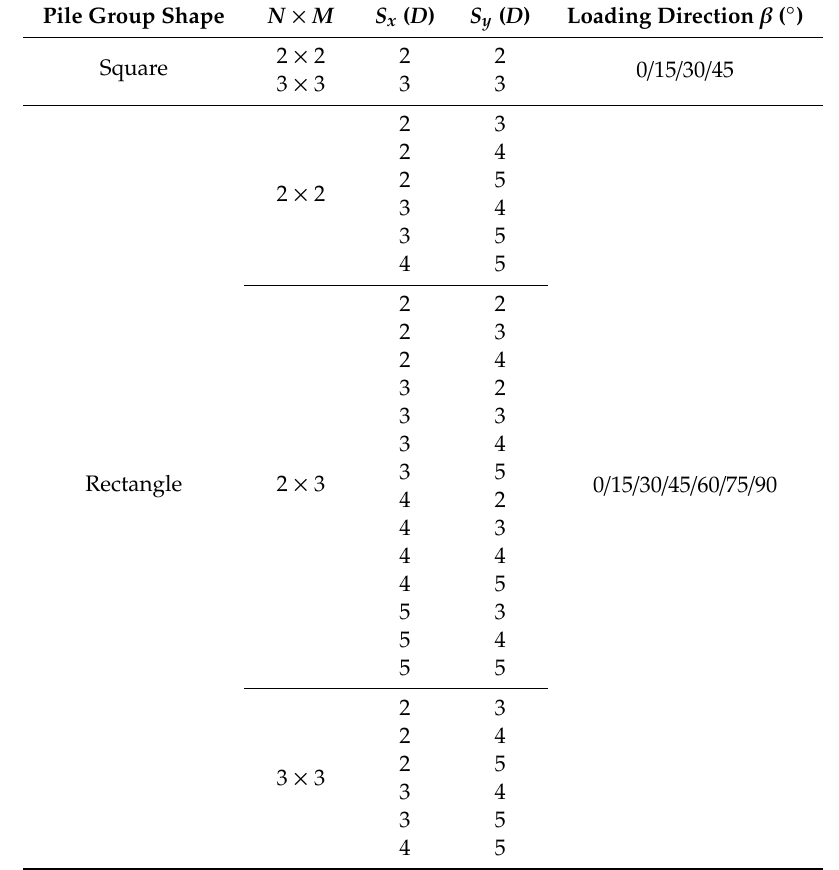
Table 4. Summary of analyzed pile group configuration. The loading direction angle was varied in 15 ◦